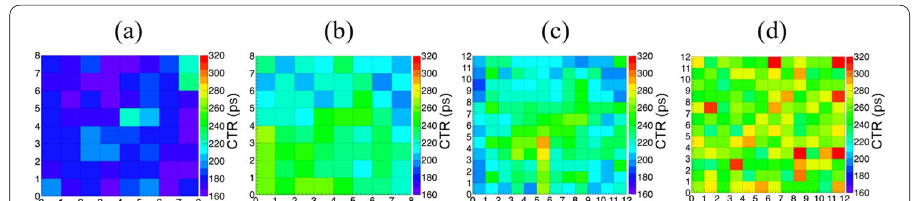
Fig. 13 CTRs of all individual crystals of the four detectors, a detector 1, b detector 2, c detector 3, d detector